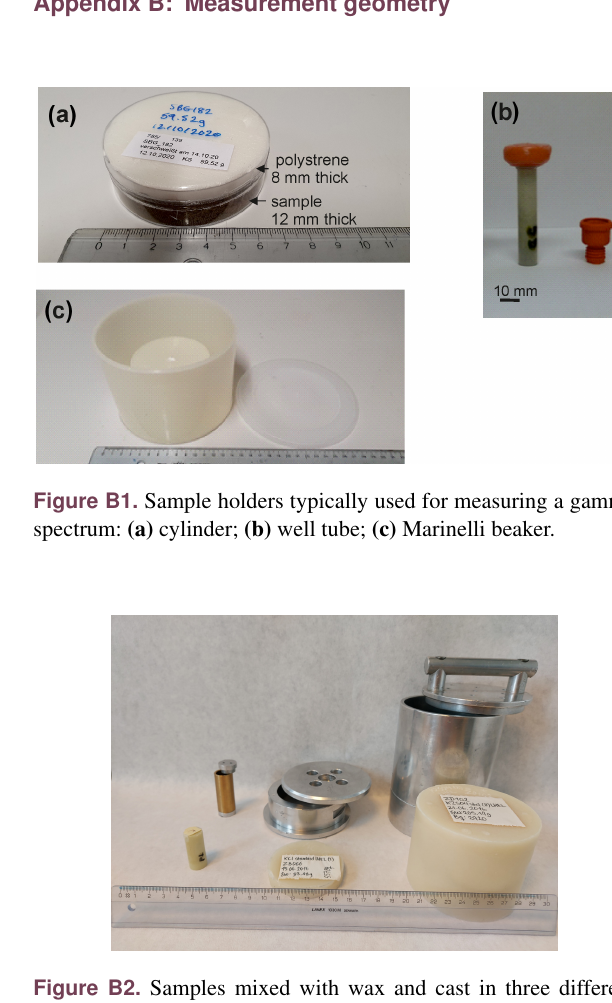
Figure B2. Samples mixed with wax and cast in three different geometries (photo kindly provided by Vicki Hansen,